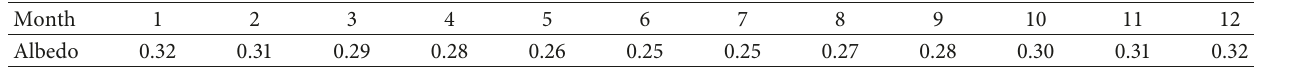
Table 2: Monthly average albedo (Tazhong station,